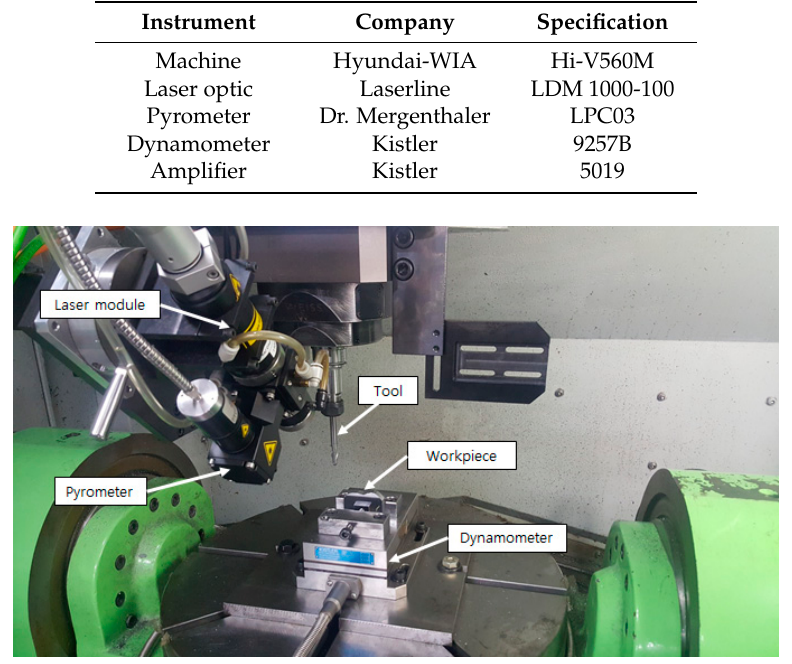
Figure 11. Experimental set-up.